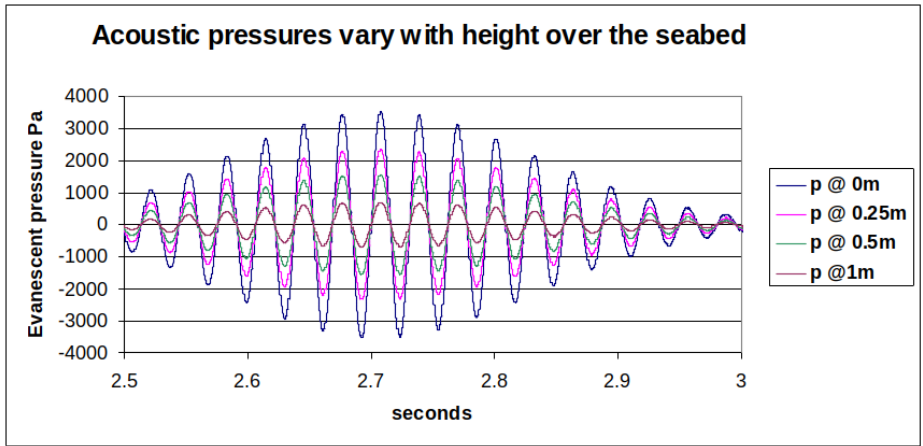
Figure 12. The pressures created at a distance of 256 m from the source are shown at different heights above the seabed. They oscillated simultaneously, independent of height. above the seabed. They oscillated simultaneously, independent of height.